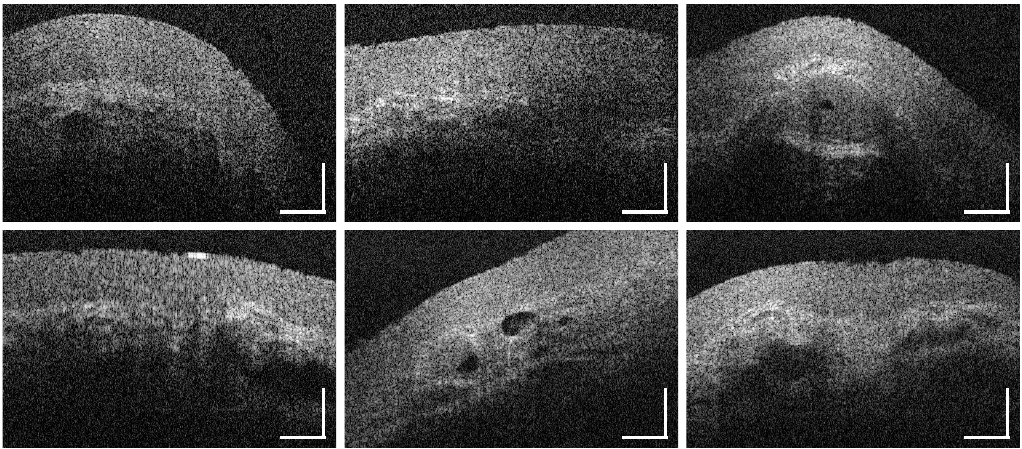
Figure A24. Supplementary intensity-based OCT cross sections of the oral mucosa of the uvula (MP14, Figure 1). Scale bars: 200 µ m.